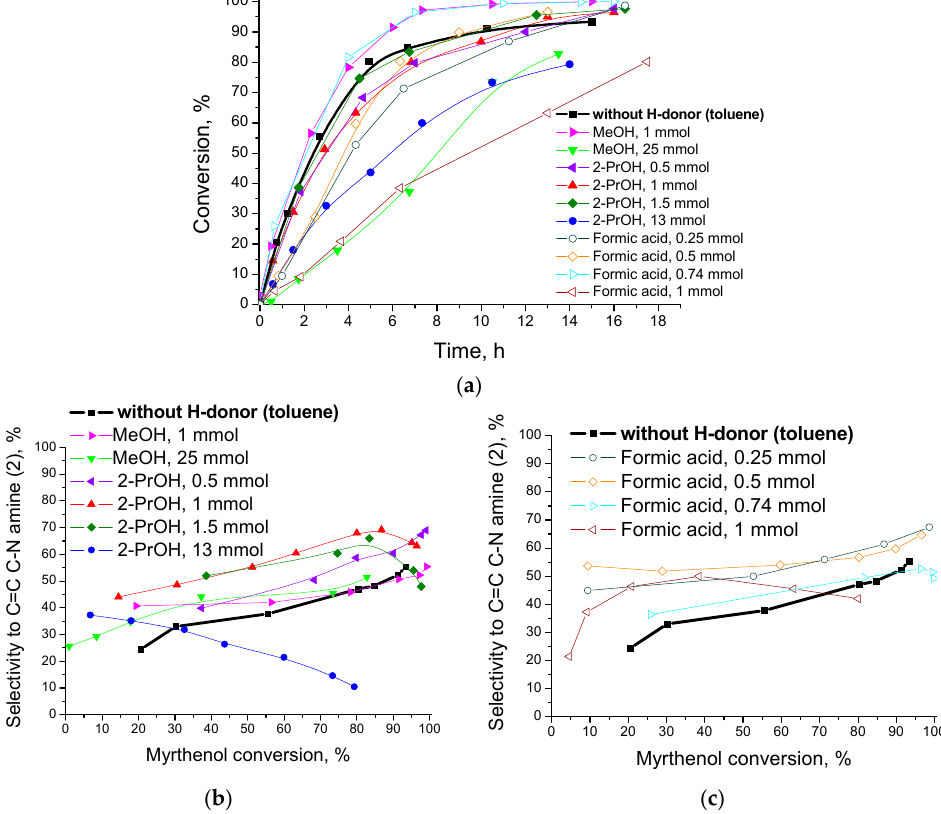
Figure 27. The effect of H-donors addition and its amount on myrtenol conversion ( a ) and selectivity to amine ( 2 ) ( b , c ). The reaction conditions: T = 180 °C, myrtenol 1 mmol, aniline 1 mmol, toluene 10 mL, Au/ZrO 2 catalyst 92 mg, 9 bar N 2 . Reprinted from [139] with permission from